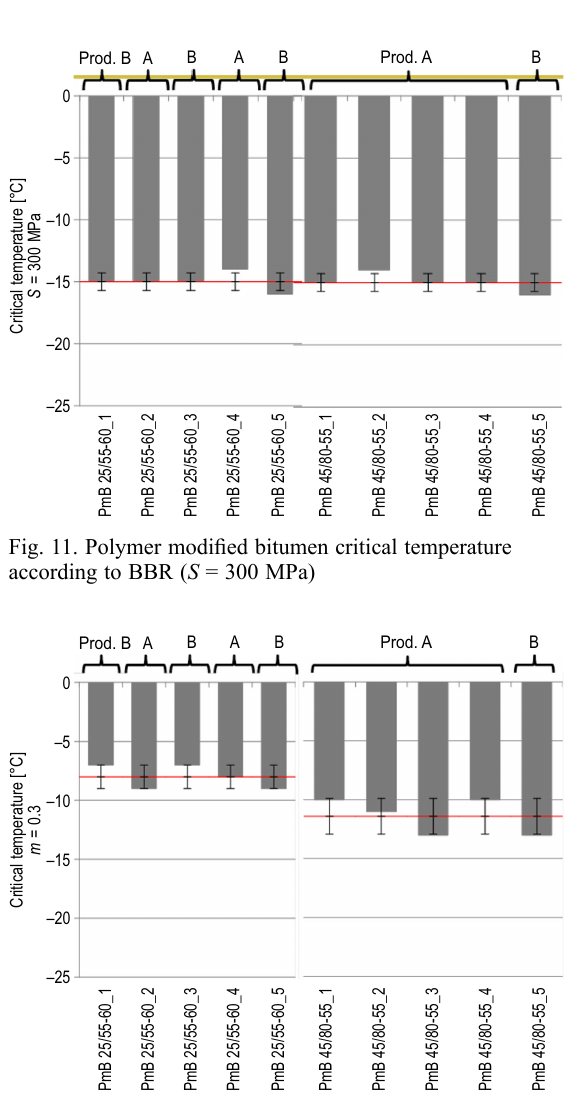
a) PmB 25/55-60 (A) b) PmB 25/55-60 (B) c) PmB 45/80-55 (A) d) PmB 45/80-55